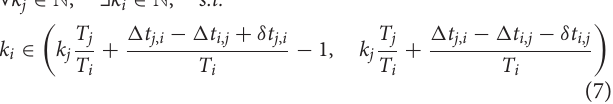
appears in a pre-defined rendezvous zone is defined as